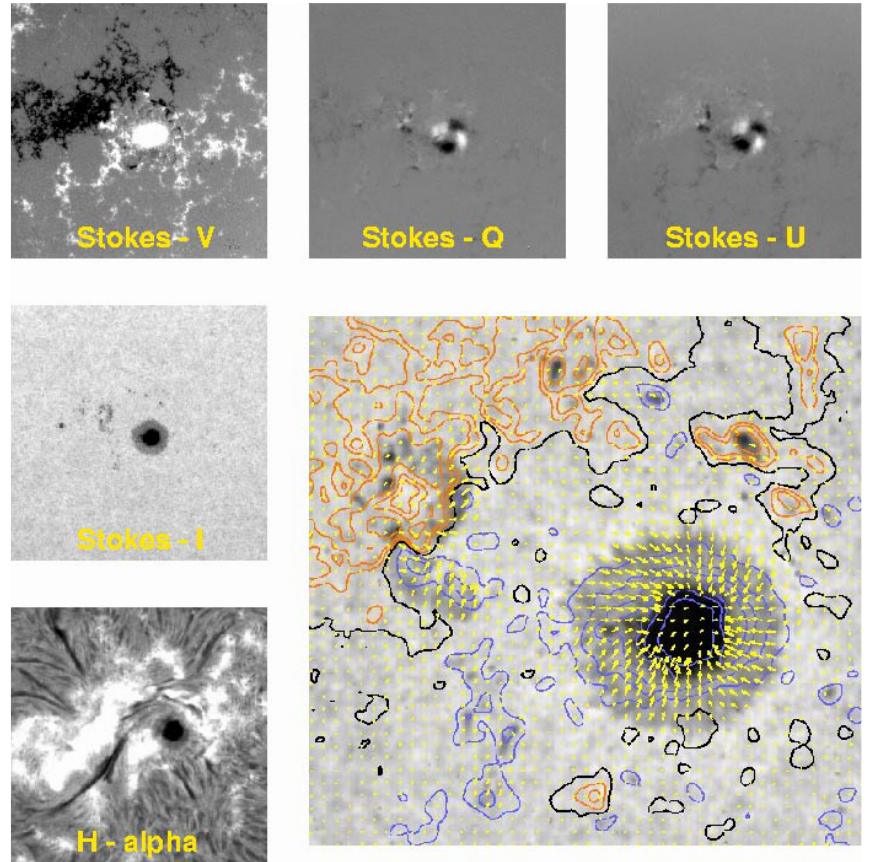
Fig. 2. Vector magnetogram of NOAA 9240 from the BBSO DVMG. The orange/blue contours indicate the positive/negative longitudinal magnetic field strength, the contour levels being 0.2, 0.4, 0.6, and 0.8 of the maximum field strength. The dark solid lines in- dicate the longitudinal field inversion lines, while the yellow arrows indicate the strength and azimuth of the trans- verse magnetic